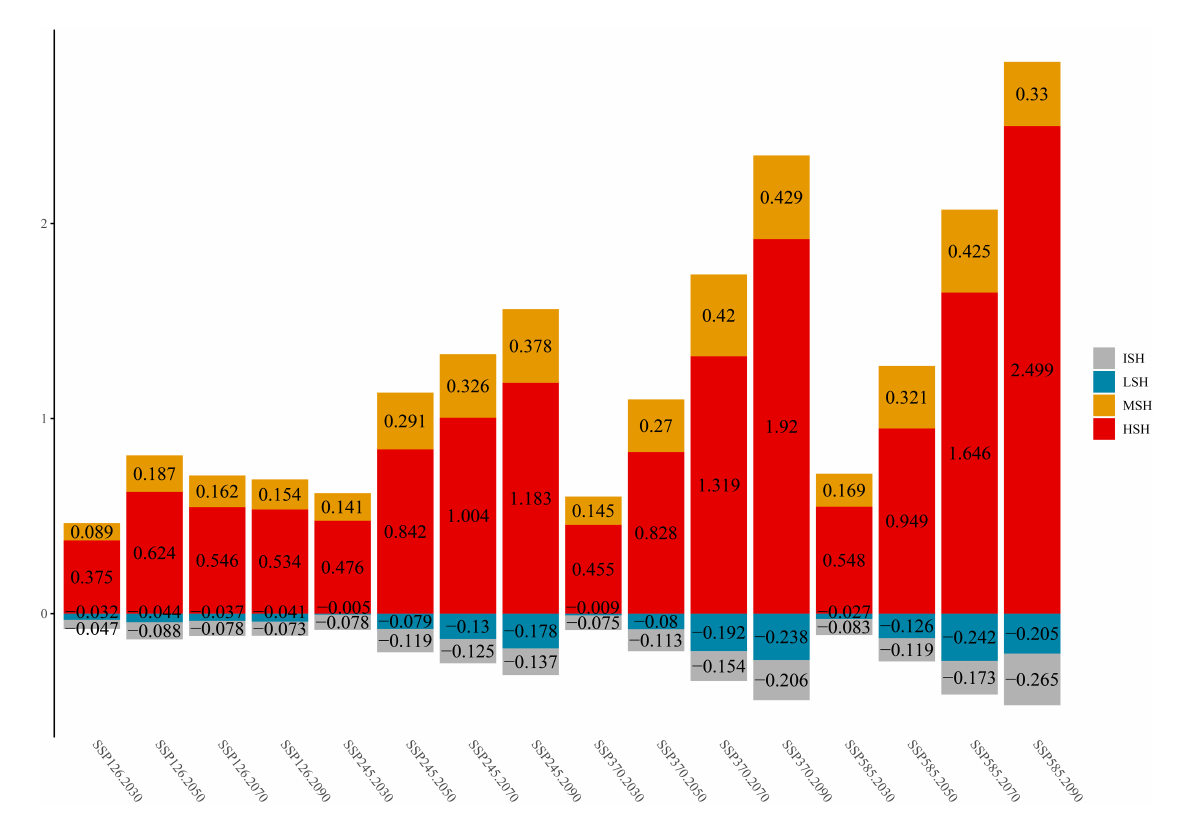
FIGURE3 The change trends of C. salsa in each scenario (comparing the areas under current conditions, the positive value is increasing, and the negative value is decreasing). ISH, inappropriate suitable habitat; LSH, low-suitability habitat; MSH, medium-suitability habitat; HSH, highly suitable habitat. Additionally, 2,030, 2,050, 2,070, and 2,090 represent 2,020–2,040, 2,040–2,060, 2,060–2,080, and 2,080–2,100.